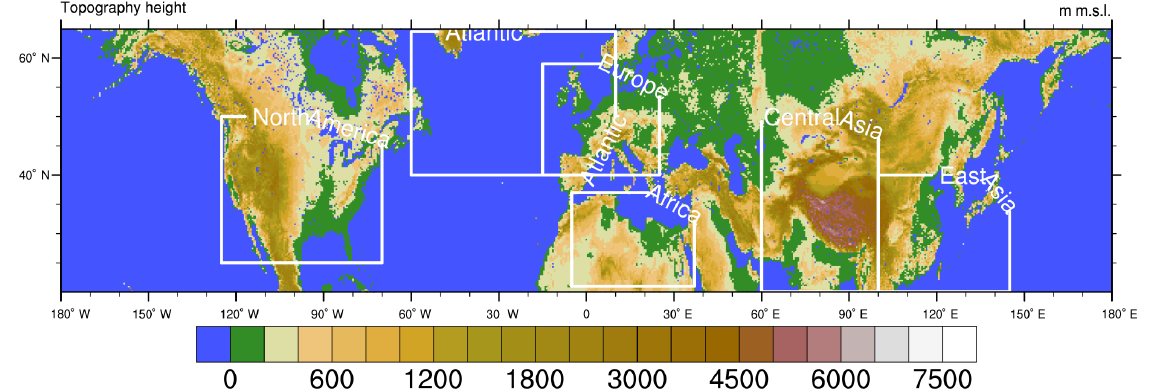
Figure 1. Model domain of the latitude-belt simulation. The white rectangles denote the domains used for verification of precipitation.